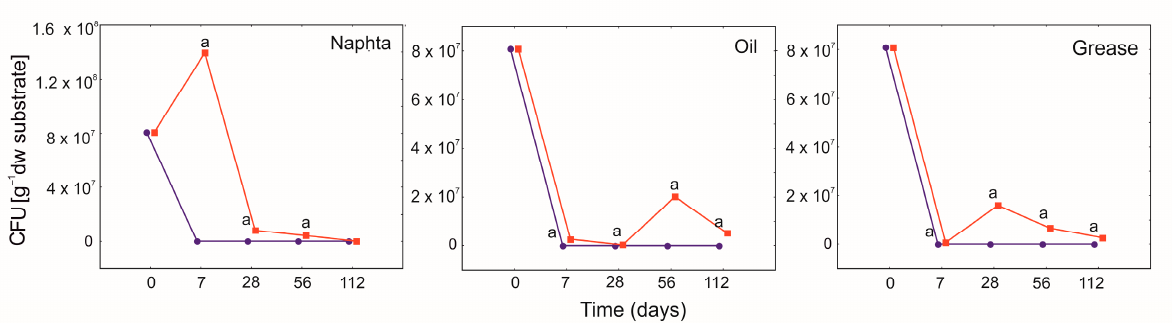
Figure 8. GLMM for microbial colony forming units (CFU) of heavy naphtha, lubrication oil, and grease for PGA 1B (red and square) and reference (blue and circle) treatment and time (days). The different letters indicate the pairwise differences according to Duncan pairwise test. Mean values, standard error, and confidence intervals are included in Supplementary Material Table S1.